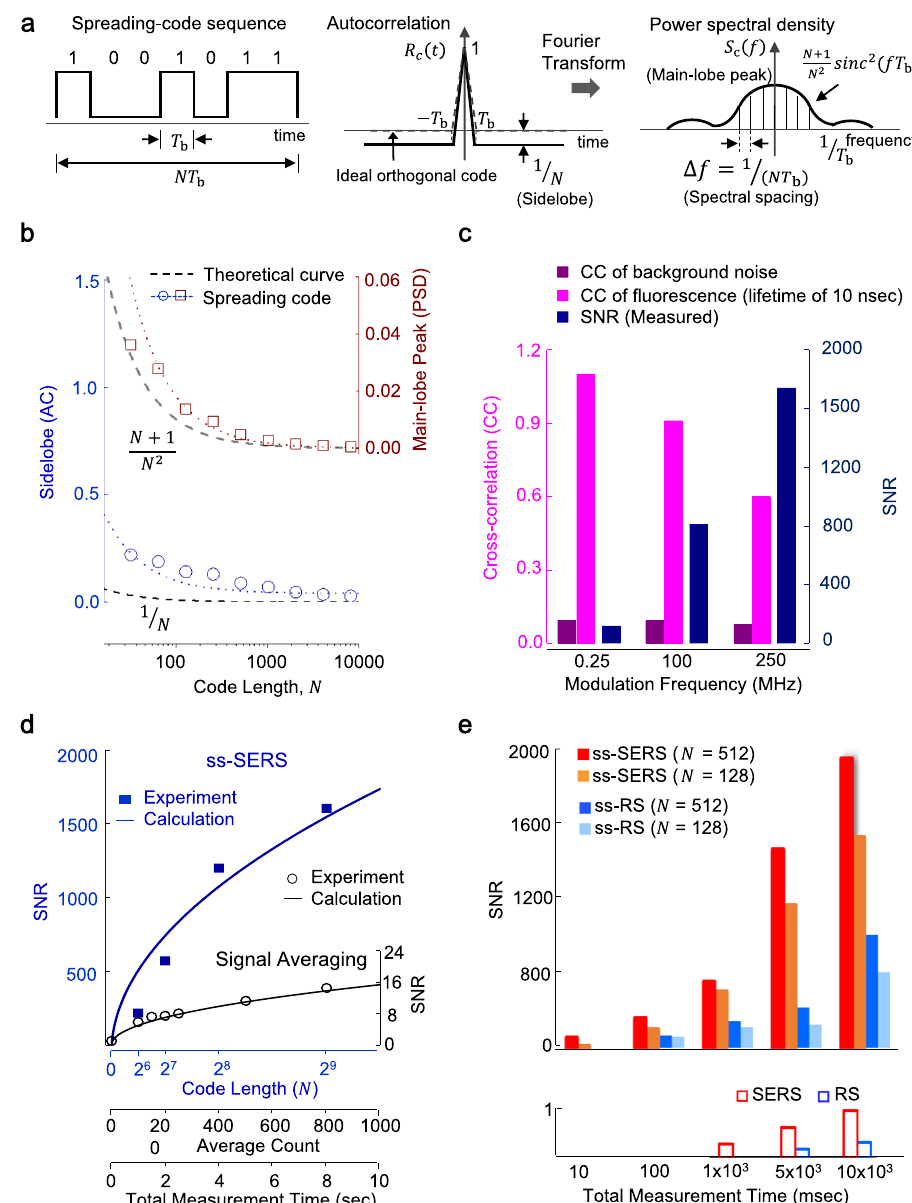
Fig. 3 The signal-to-noise ratio of ss-SERS depends on the code length of a PN code and the modulation frequency. a Conceptual description of the autocorrelation and power spectral density of the spreading codes as high orthogonal codes based on primitive polynomials. T b , N , R c ( τ ), and S c ( τ ) represent a bit duration, code length, autocorrelation function, and power spectral density function, respectively. b The autocorrelation (AC) sidelobe and the main-lobe peak dependence on the PN code length. The autocorrelation sidelobe and the main-lobe peak for the high orthogonal code decrease to the theoretical level as the code length increases, resulting in signi fi cant noise suppression. c The cross-correlation (CC) and the measured SNRs of ss-SERS for R6G molecules at 1331 cm − 1 dependence on the modulation frequency. The cross-correlation of the fl uorescence generated by excitation light decreases with increasing modulation frequency, however, the cross-correlation for the background noise independent of the excitation light remains near-zero. d Comparison of the measured SNRs between the ss-SERS and the signal averaging for R6G molecules at 1331 cm − 1 . The total measurement time corresponds to the code length multiplied by a constant sequence repetition and bit duration as well as the average count multiplied by a constant sweep time. The ss-SERS measurement shows an exceptional improvement in the SNR by over two orders of magnitude compared to the signal averaging of the SERS signals. e Comparison of the temporal resolution between ss-SERS/ss-RS and conventional SERS/RS. The ss-SERS exhibits a substantial reduction in the measurement time over 100th compared to conventional SERS and The measured SNR of ss-SERS and the signal averaging signals are than that of the signal averaging for an 8 s measurement time. The well matched with the theoretical coding gain curve of Eq. (6) (see suppression mechanism of fl uorescence signals at a modulation “ Methods ” section for SNR calculation of the ss-SERS). Notably, frequency of 250 MHz can be explained in Supplementary Fig. 6 the ss-SERS signals show an exceptional improvement in the SNR and the comparison between the ss-SERS and modulated-based compared to the signal averaging of SERS signals. For instance, the SERS is summarized in Supplementary Table 2. The peak SNR of ss-SERS signal is over two orders of magnitude greater autocorrelation of the spreading code completely restores the